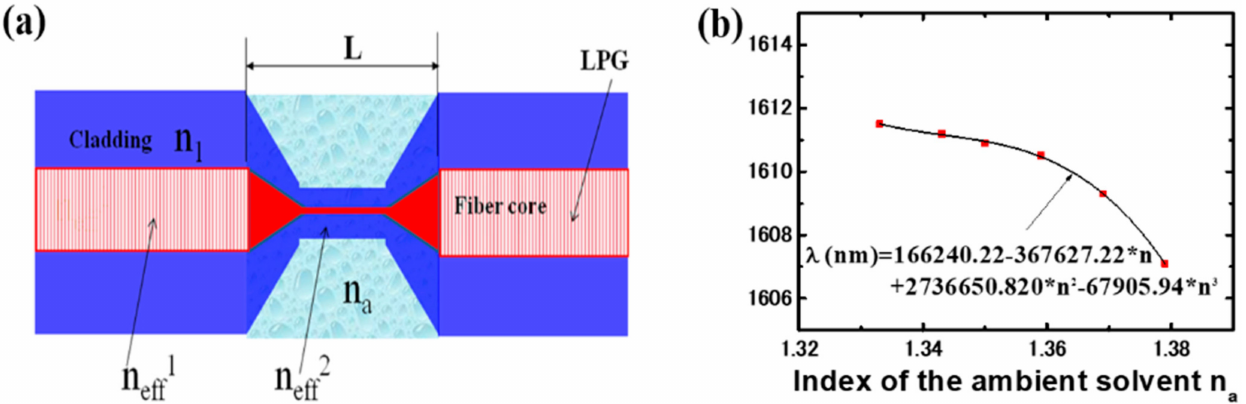
Figure 31. ( a ) Schematic diagram of the tapered fiber-based phase-shifted LPG. ( b ) Dependent of the peak wavelength on the refractive index of the ambient solvent. Adapted with permission from ref. [151]. © The Optical